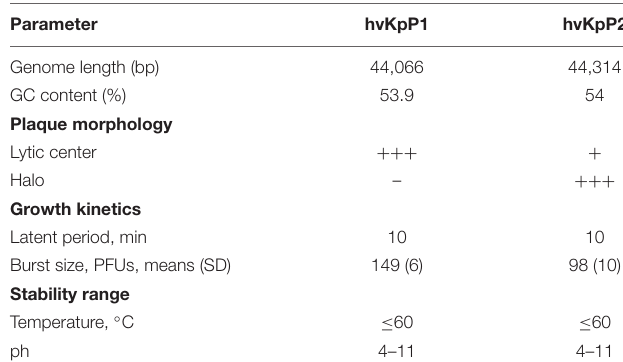
TABLE 2 | Summary phage